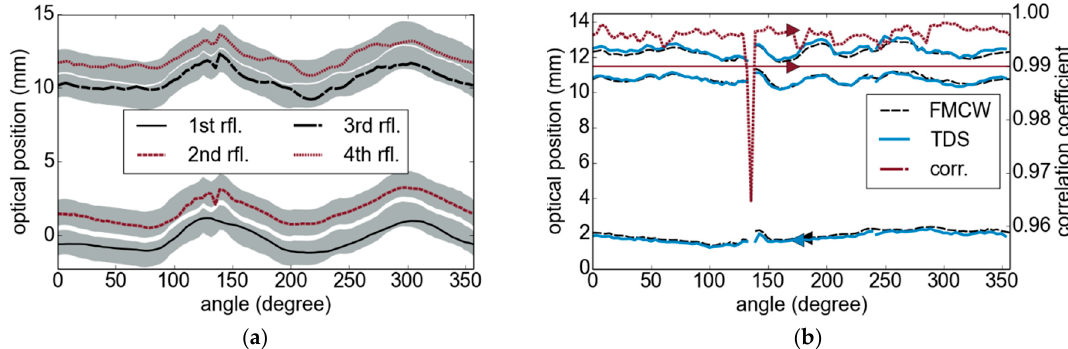
Figure 8 . ( a ) Optical positions (optical path length differences) of the reflecting boundary surface. ( b ) Comparison of time-domain spectroscopy (TDS) and frequency-modulated continuous-wave (FMCW) measurements: the first boundary surface is used as the reference plane to adjust the values.